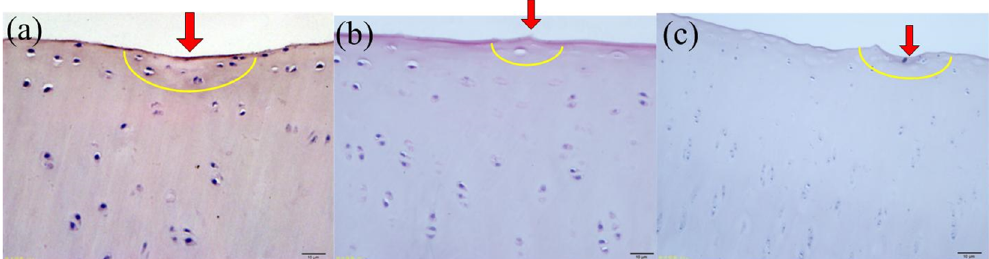
Fig. 11 HE staining of PEEK/cartilage under different stress. a 1 MPa; b 2 MPa; c 3